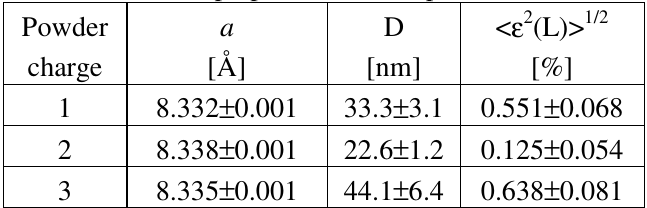
Table 1 . Values of lattice parameters ( a ), average crystallite size (D) and crystal lattice microstrains ( e